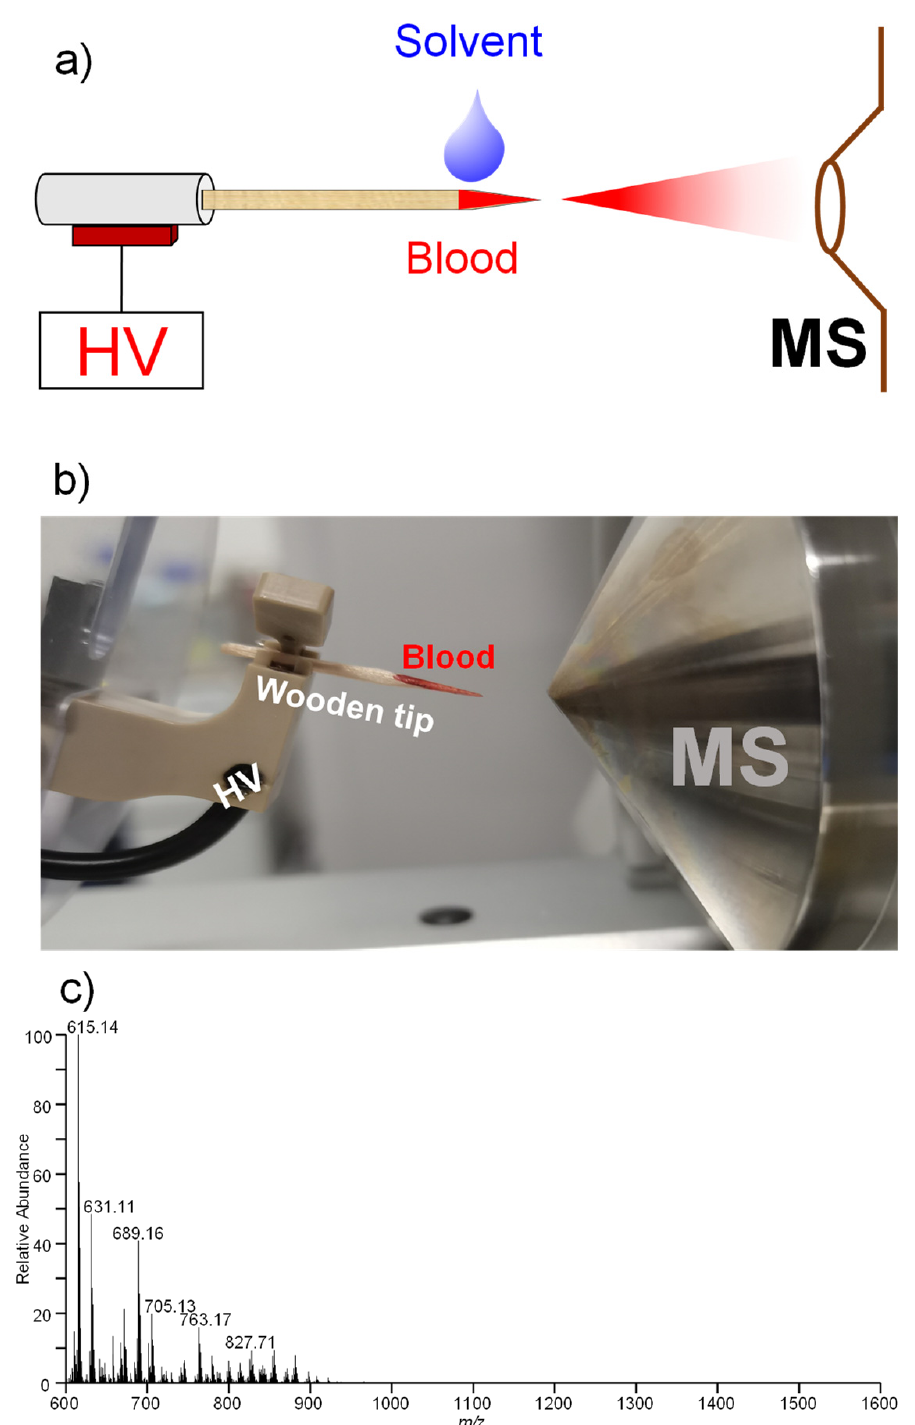
Figure 1. ( a ) Schematic diagram and ( b ) picture of WT-ESI-MS for direct analysis of blood samples; ( c ) background signal of a wooden tip with solvent only.